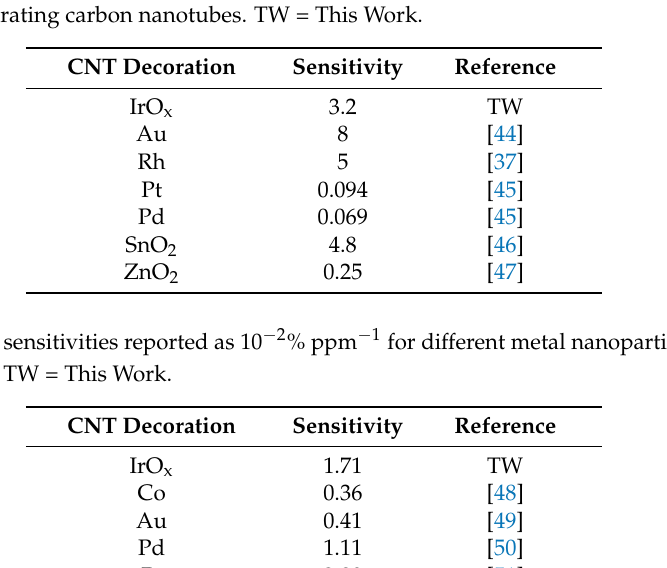
Table 2. Nitrogen dioxide sensitivities reported as 10 − 3 % ppb − 1 for different metal or metal oxide nanoparticles decorating carbon nanotubes. TW = This Work.